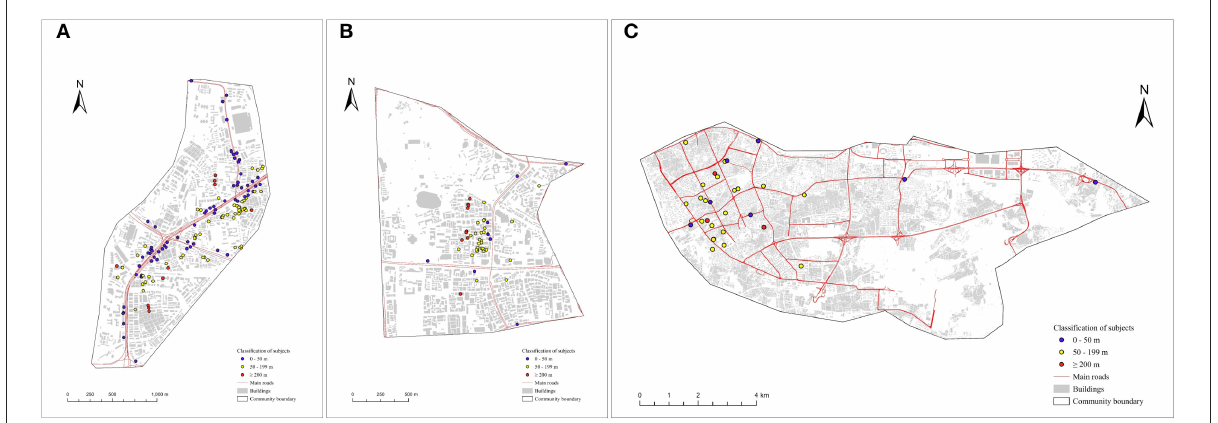
FIGURE1 (A–C) Classification of subjects based on distance of each home from the main road in Nanyuan, Hongqiao and Xingang Community. The three maps represented classification of subjects according to distance of each home from the main road ( < 50m, 50–199m, and ≥ 200m groups) in Nanyuan, Hongqiao and Xingang